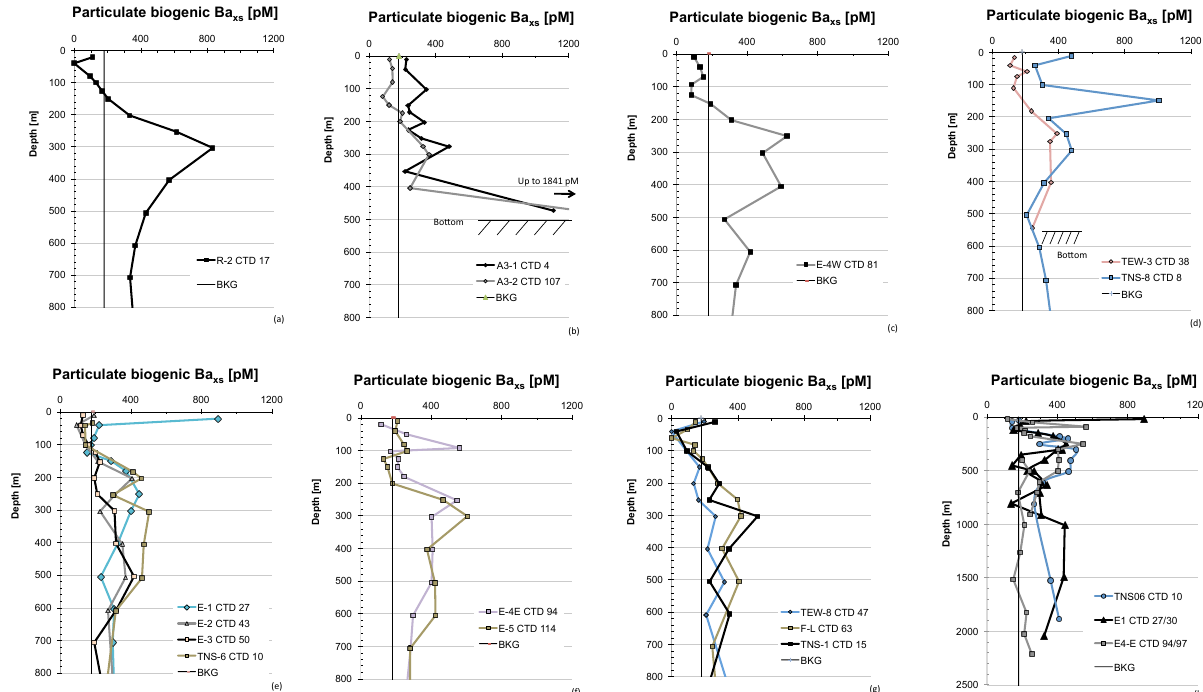
Figure 4. Particulate biogenic Ba xs profiles (pM) in the upper 800m (Fig. 4a–g) and in the upper 2500m (Fig. 4h). Stations are identified by CTD cast numbers. BKG: Ba xs background